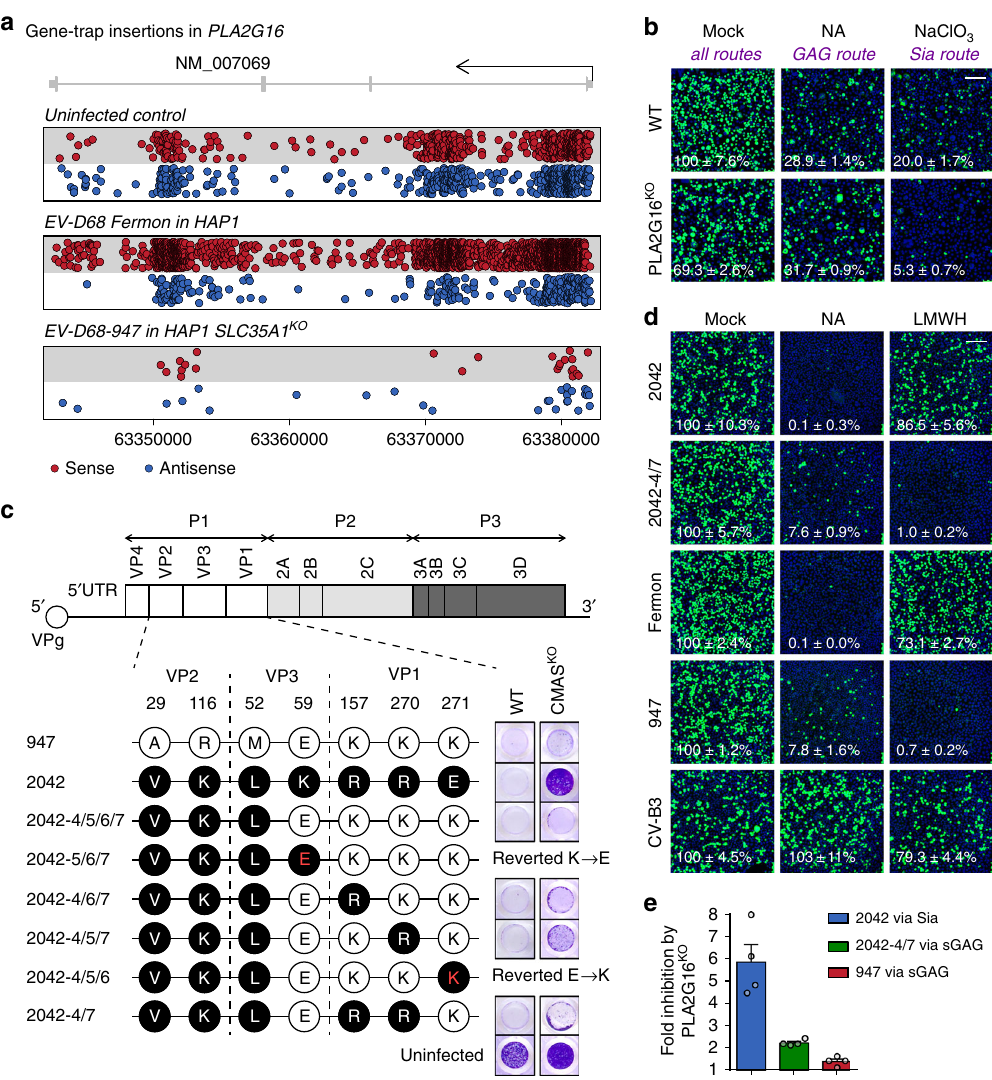
Fig. 2 Engagement of sGAGs reduces the PLA2G16 dependency of EV-D68. a RefSeq gene structure of PLA2G16 with genomic positions at the bottom. Each circle represents a sense (red) or antisense (blue) gene-trap insertion, a retroviral insert that disrupts the coding sequence of a gene when introduced in sense orientation into an intron, or in any orientation into an exon. An overall enrichment of disruptive sense gene-trap insertions (re fl ecting a role of PLA2G16 in virus infection) was observed in a haploid genetic screen with EV-D68-Fermon 15 , but not in a screen with EV-D68-947. b WT or PLA2G16 KO H1-HeLa cells were treated with neuraminidase (NA), sodium chlorate (NaClO 3 ) or a combination of both and infected with EV-D68-947, followed by staining of dsRNA (green) and nuclei (blue). Values denote the number of infected cells (mean± s.e.m. of four technical replicates) as percentage of mock- treated WT cells. Shown are representative confocal micrographs. The experiment was conducted twice with similar results. c Top, schematic representation of the enterovirus genome, with the 5 ′ untranslated region (5 ′ UTR), precursor proteins P1-P3, capsid proteins VP1-VP4 and non-structural proteins 2A-2C, 3 A, 3B (or VPg), 3C, and 3D. Bottom, EV-D68-947 and 2042 differ in seven capsid residues, which were exchanged by site-directed mutagenesis. Red letters indicate positions at which mutants reverted back to the 947 genotype. WT or CMAS KO HAP1 cells were exposed to EV-D68 mutants and live cells were stained with crystal violet at 6 days post infection. d Viruses were incubated with low-molecular-weight-heparin (LMWH), followed by infection of mock- or NA-treated HeLa-R19 cells and staining of dsRNA (green) and nuclei (blue). Shown are representative confocal micrographs. Scale bars: 150 µ m. Values denote the number of infected cells (mean ± s.e.m. of three technical replicates) as percentage of mock. e WT or PLA2G16 KO H1-HeLa cells were infected and stained for dsRNA, followed by quanti fi cation of infected cells. Fold inhibition by PLA2G16 KO was calculated by dividing the number of infected cells in PLA2G16 KO cells by that in WT cells (see Supplementary Fig. 2f). Error bars: mean ± s.e.m. of four technical replicates. The experiment was conducted twice with similar